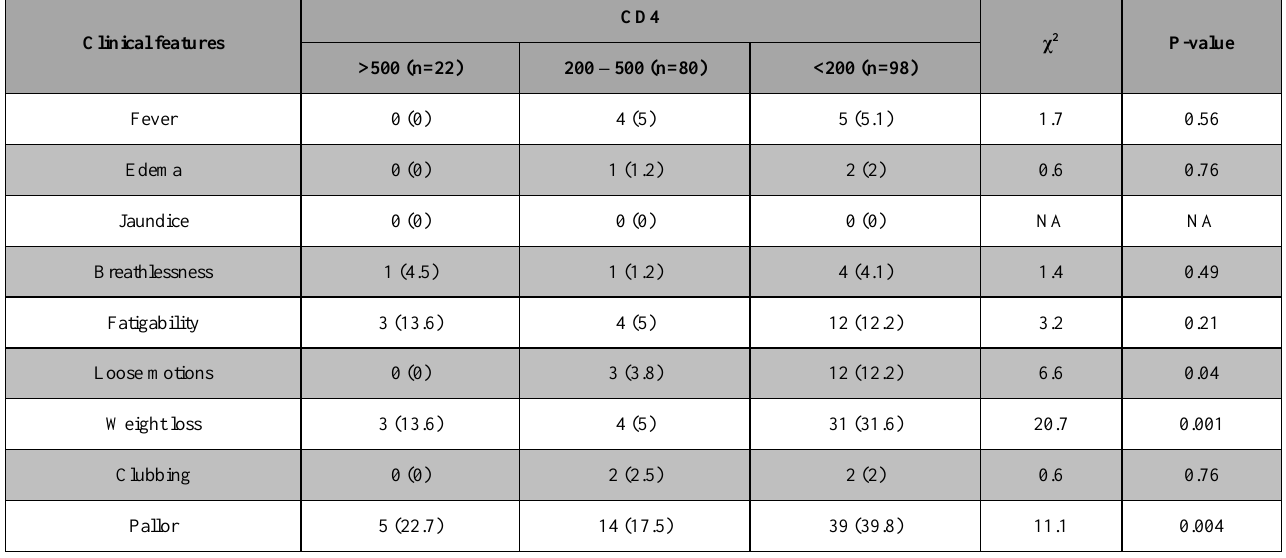
Table 2. Association of CD4 count with clinical